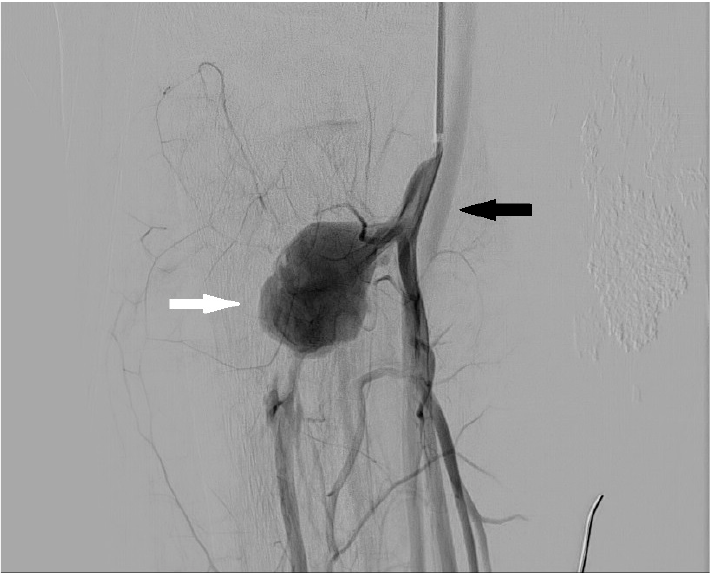
Figure 9. Post-traumatic pseudoaneurysm of proximal anterior tibial artery (white arrow) associated with arteriovenous fistula (black arrow).